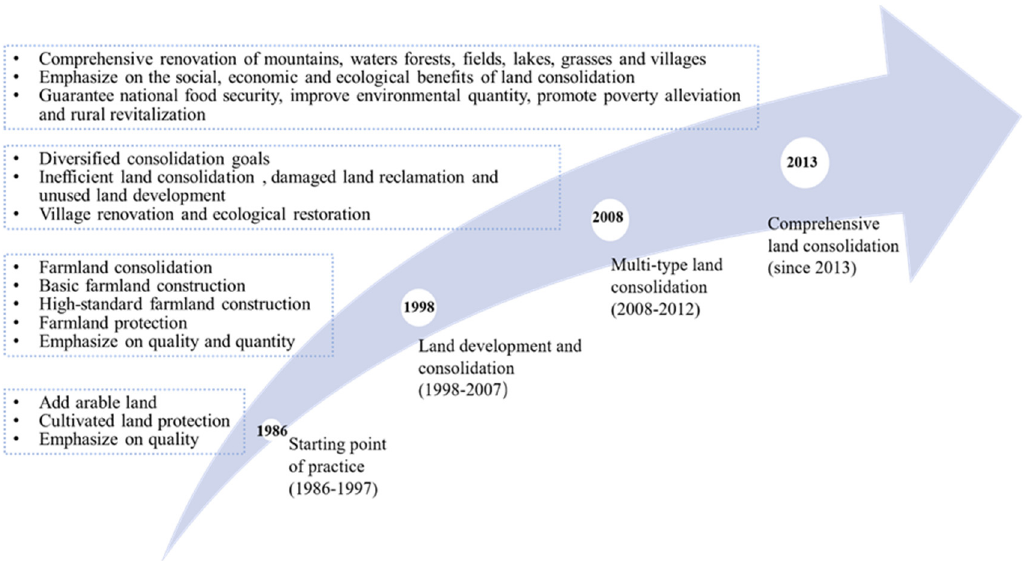
Figure 6. Scientific production distribution in the field of land consolidation.